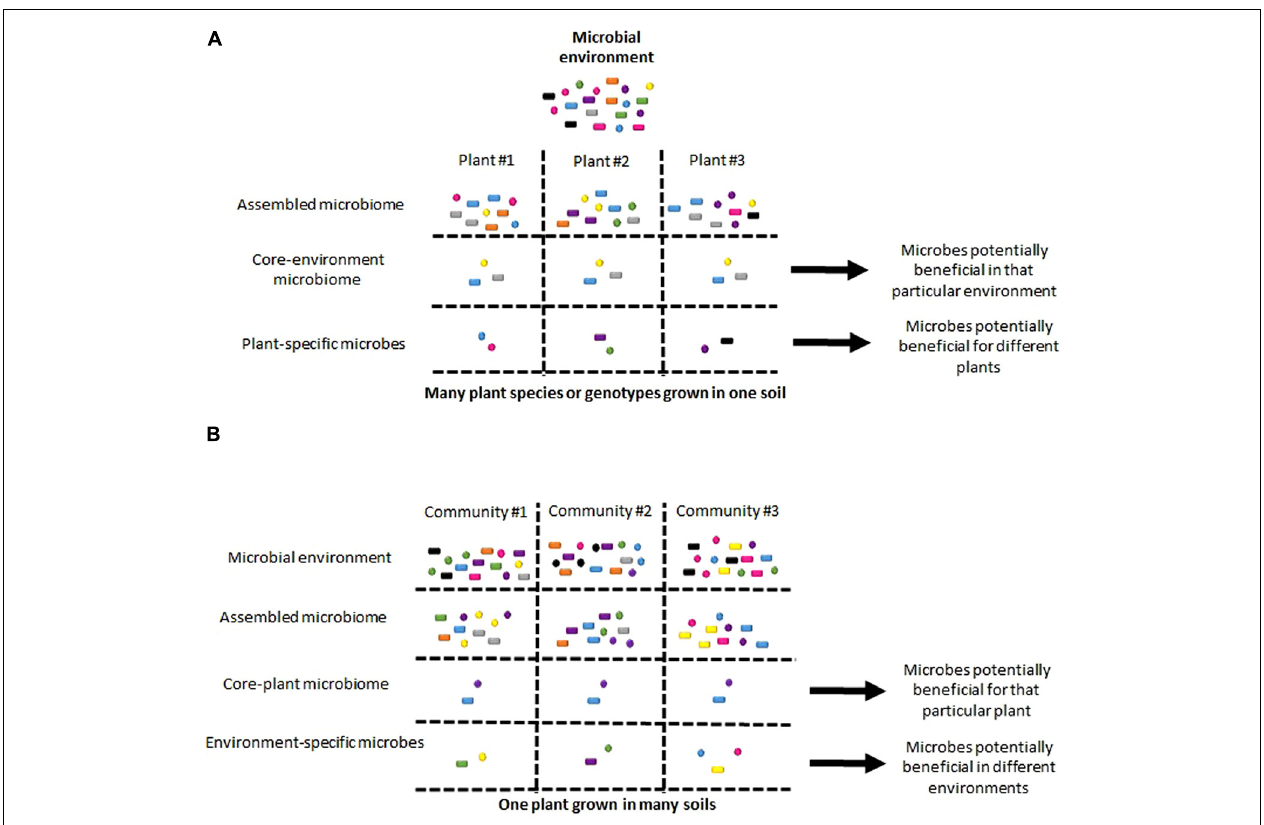
FIGURE 2 | Comparing “core” and “specific” plant microbiome members. Potential conclusions that might be made for “core” and “specific” microbes when comparing communities from (A) many species/genotypes of plant